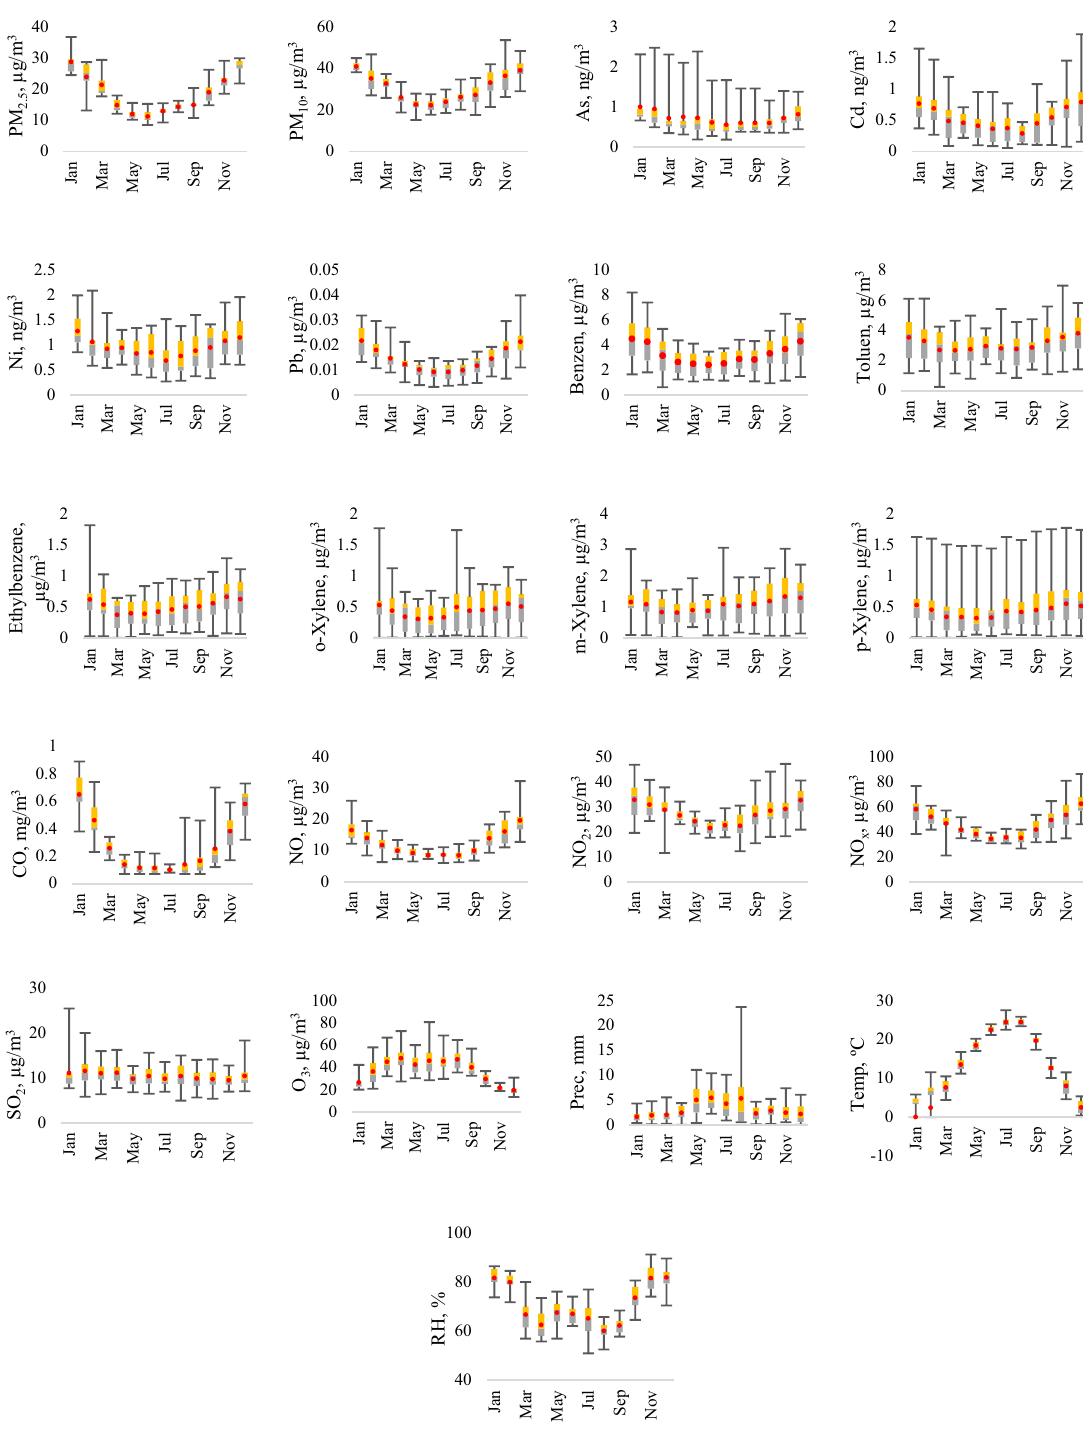
Figure 3. Multiannual monthly variation of the studied air